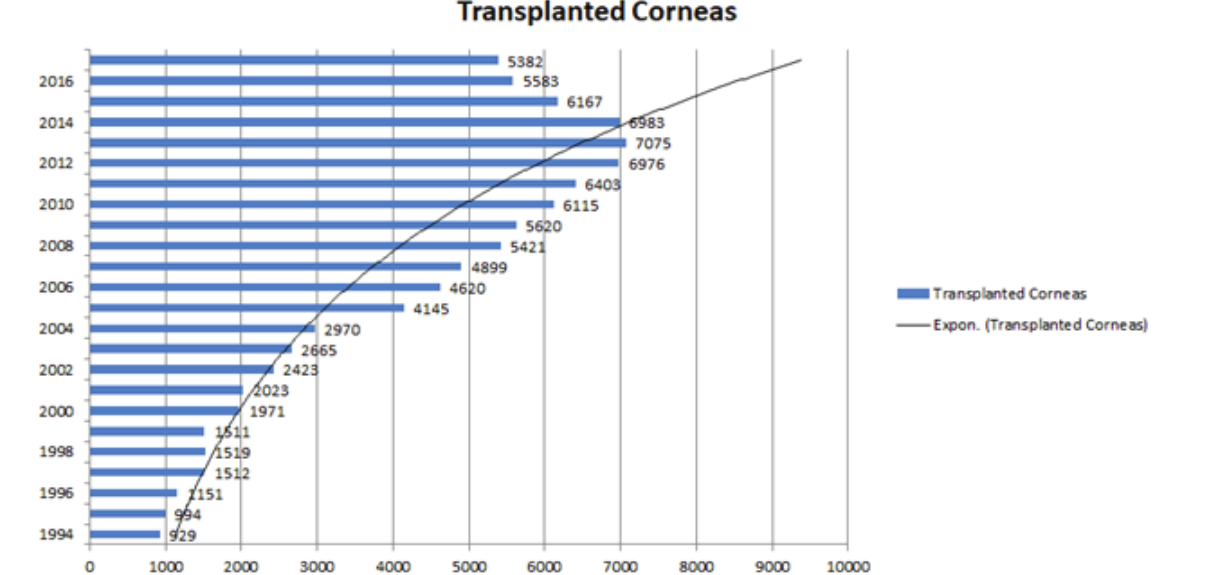
Figure 2. The annual rate of keratoplasties in Iran. Note the increasing rate of corneal transplantation between 1994 and 2016.